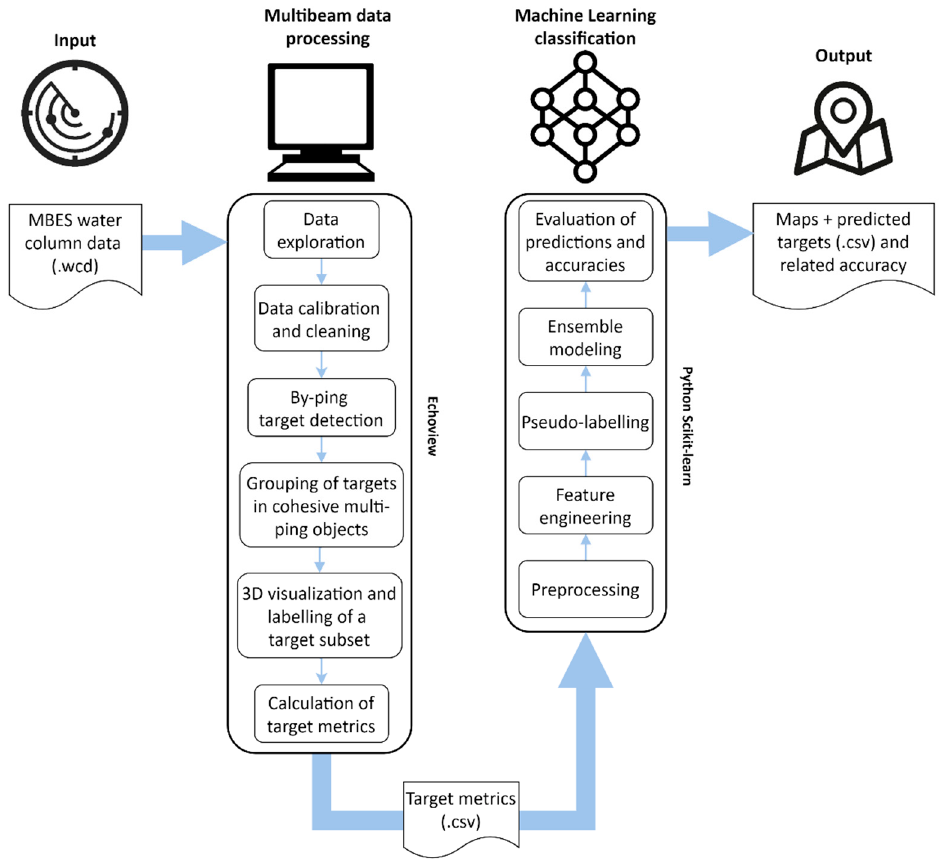
Figure 1. Overview diagram of the full workflow.